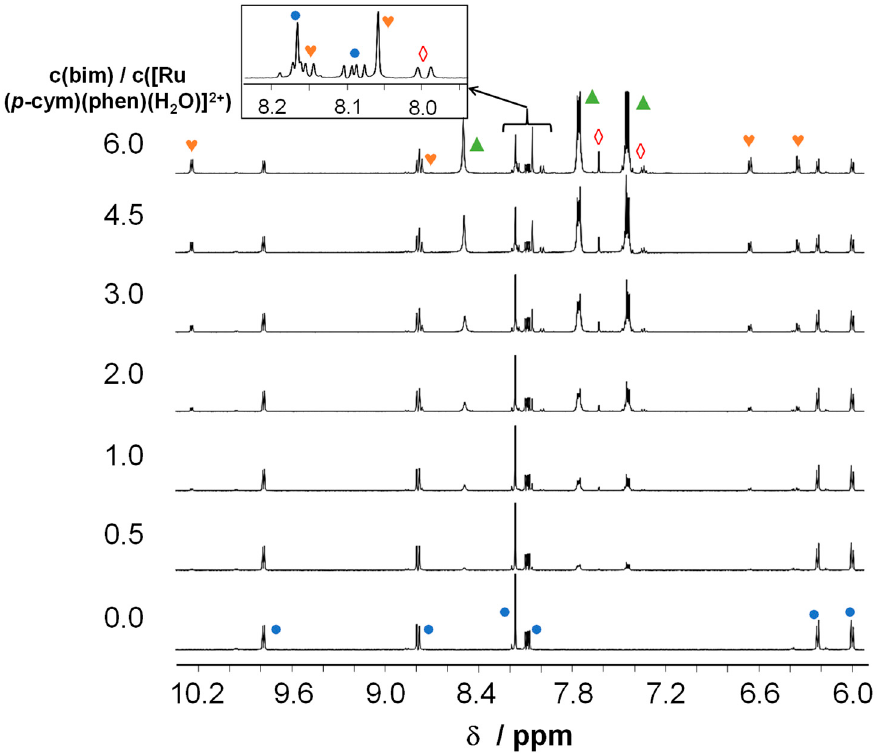
Figure 4. Low‑field region of 1 H NMR spectra of ([Ru( p ‑cym)(phen)(H 2 O)] 2+ at various benzimida‑ Figure 4. Low ‐ field region of 1 H NMR spectra of ([Ru( p ‐ cym)(phen)(H 2 O)] 2+ at various benzimidaz ‐ zole/complex ratios. Peak assignation: [Ru( p ‑cym)(phen)(H 2 O)] 2+ : • ; free benzimidazole: ▲ ; [Ru( p ‑ ole/complex ratios. Peak assignation: [Ru( p ‐ cym)(phen)(H 2 O)] 2+ : ● ; free benzimidazole: ▲ ; [Ru( p ‐ cym)(phen)(bim)] 2+ : ￿ ; co‑ordinated benzimidazole: ♢ . { c ([Ru( p ‑cym)(phen)(H 2 O)] 2+ ) = 300 µ M; cym)(phen)(bim)] 2+ : ♥ ; co ‐ ordinated benzimidazole: ◊ . { c ([Ru( p ‐ cym)(phen)(H 2 O)] 2+ ) = 300 μ M; pH = ◦ pH = 5.95 (PBS‘); 10% D 2 O; t = 25.0 5.95 (PBS‘); 10% D 2 O; t = 25.0 °C}.